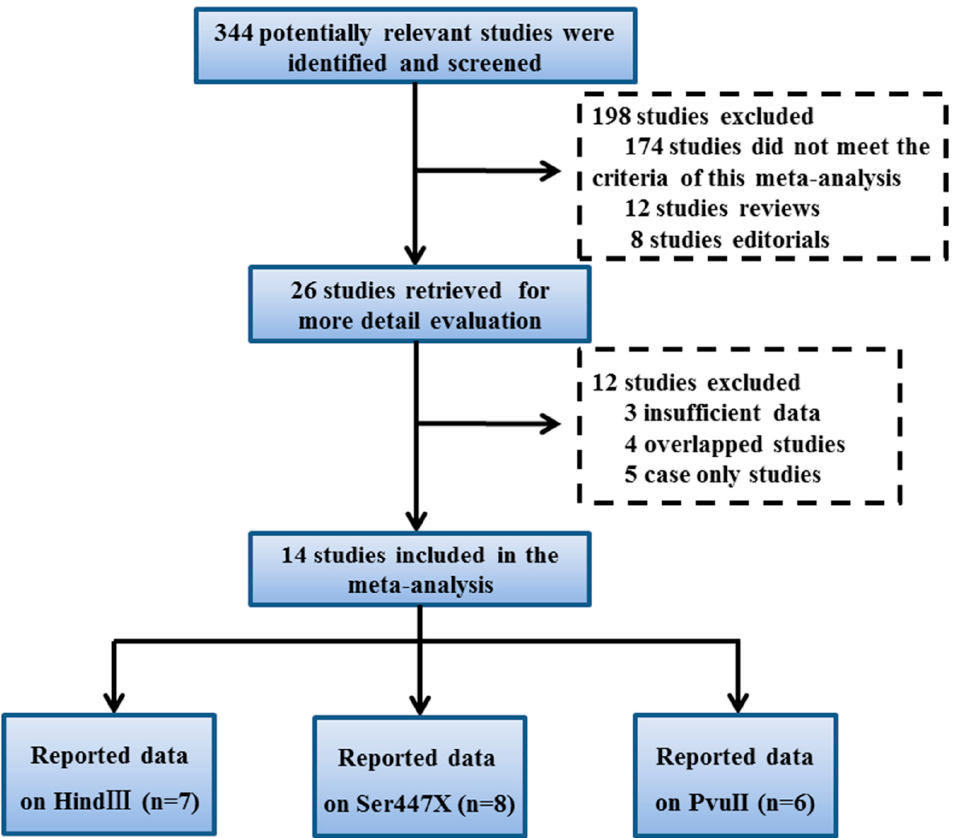
Figure 1. Flow of study identification, inclusion, and exclusion. Table 1. Characteristics of studies included in meta-analysis.